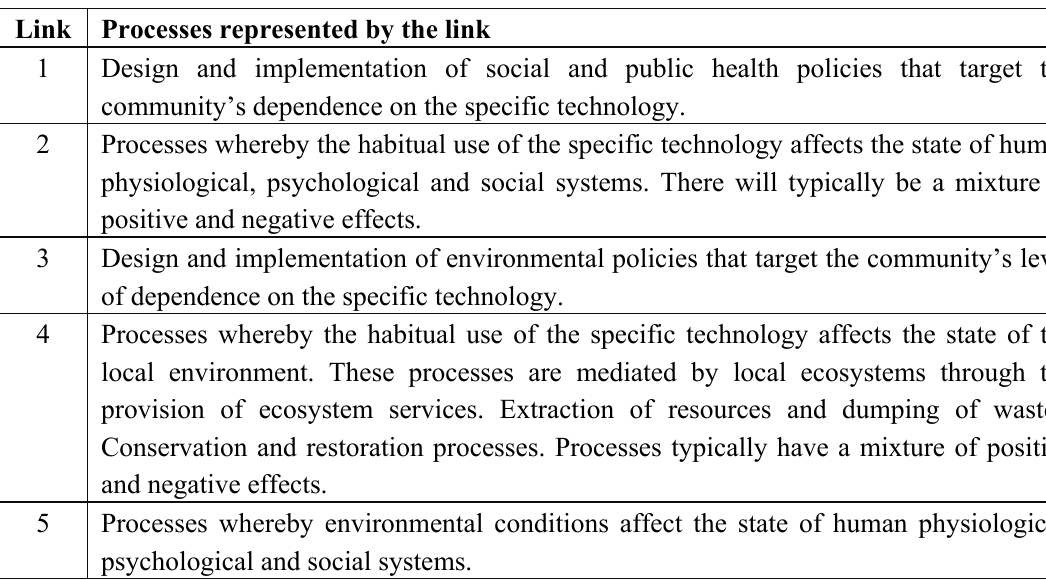
Table 3. The causal links of Figure